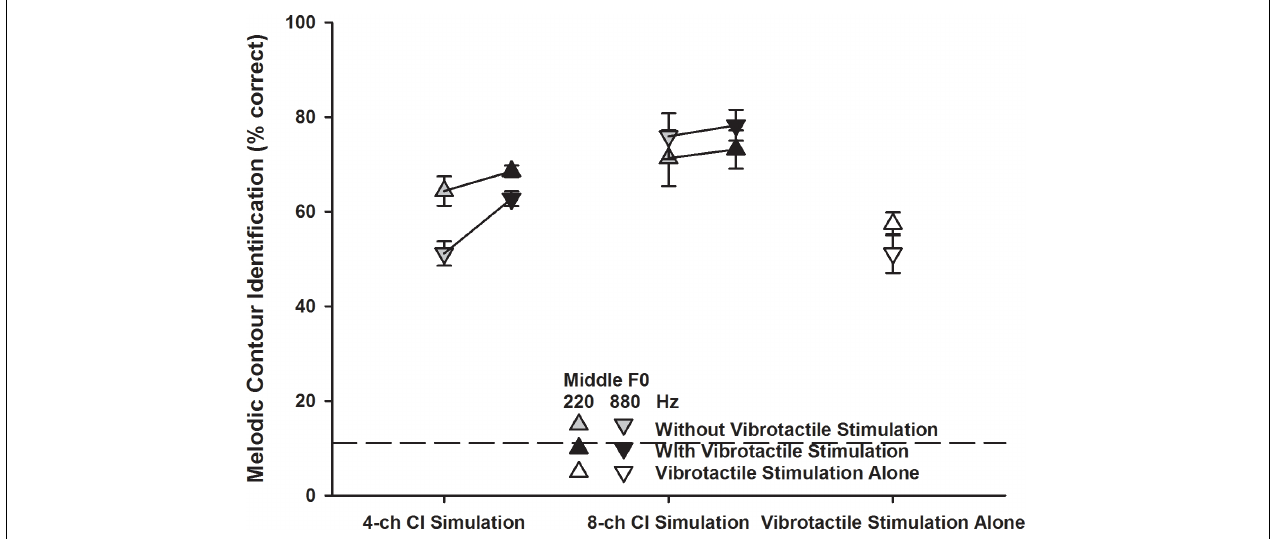
FIGURE 5 | Melodic contour identification scores for the 220 and 880 Hz middle F0s (upward and downward triangles, respectively) with the 4- or 8-channel CI simulation (left and middle line plots, respectively) with or without vibrotactile stimulation (black and gray triangles, respectively) or with vibrotactile stimulation alone (white triangles). Symbols represent the mean, while error bars represent the standard error across participants. The horizontal dashed line indicates the chance performance of 11% correct.